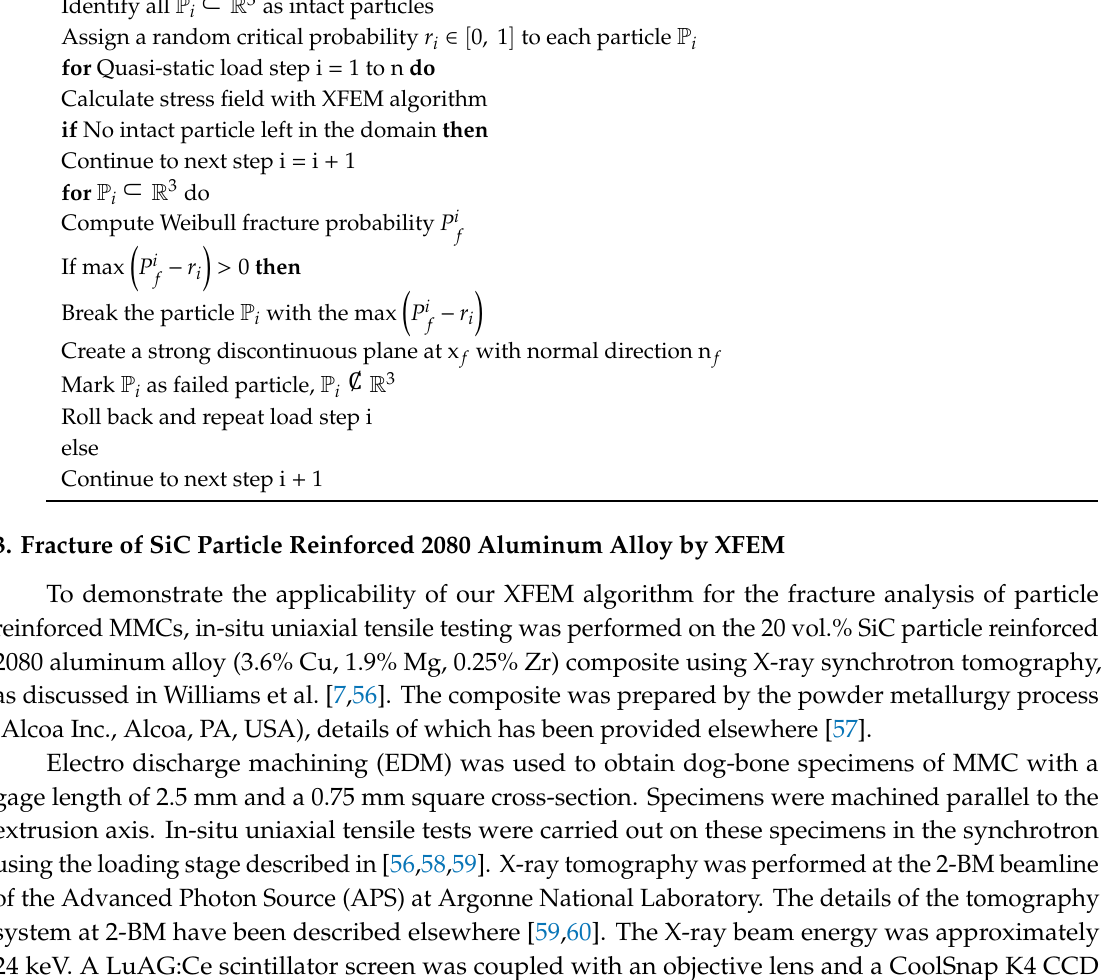
Algorithm 1 Particle fracture